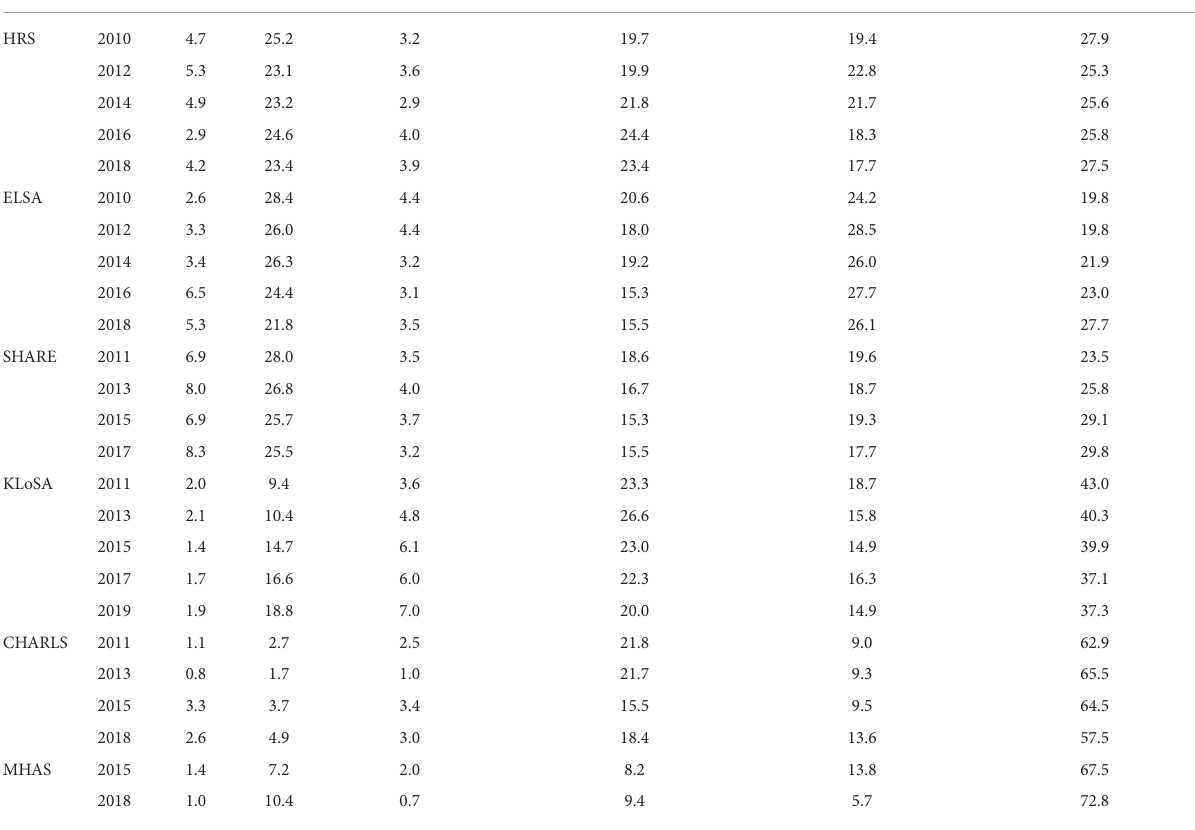
TABLE 3 Dominance of factors by cohort. Gender Age Social connection Socioeconomic position Behavioral factors Physiological risk